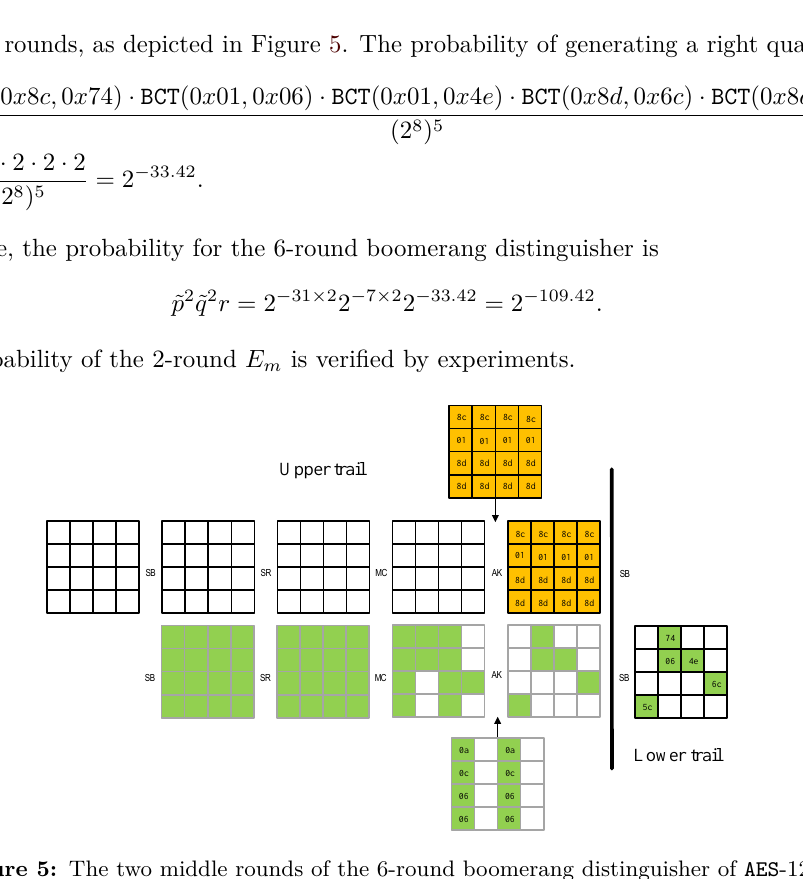
Figure 5: The two middle rounds of the 6-round boomerang distinguisher of AES